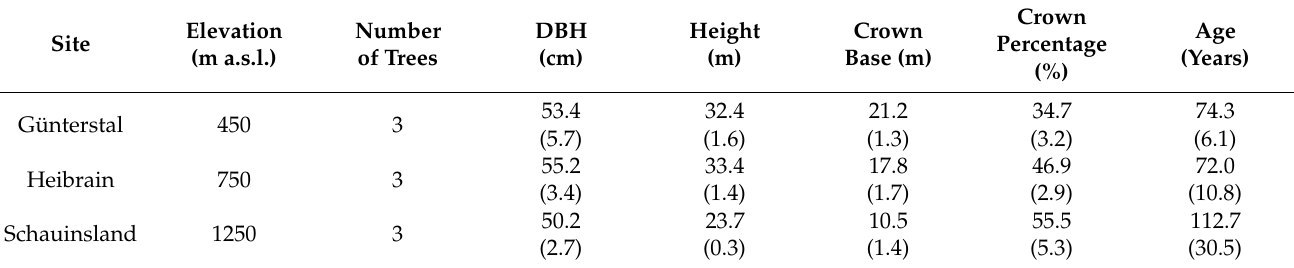
Table 1. Sample size, arithmetic mean, and standard deviation (in parentheses) of diameter at breast height (DBH), tree height, height of crown base, crown percentage, and cambial age at breast height of the studied Norway spruce trees grouped by elevation. All trees were selected for dendrometer monitoring, microcore sampling, and wood anatomical analyses during